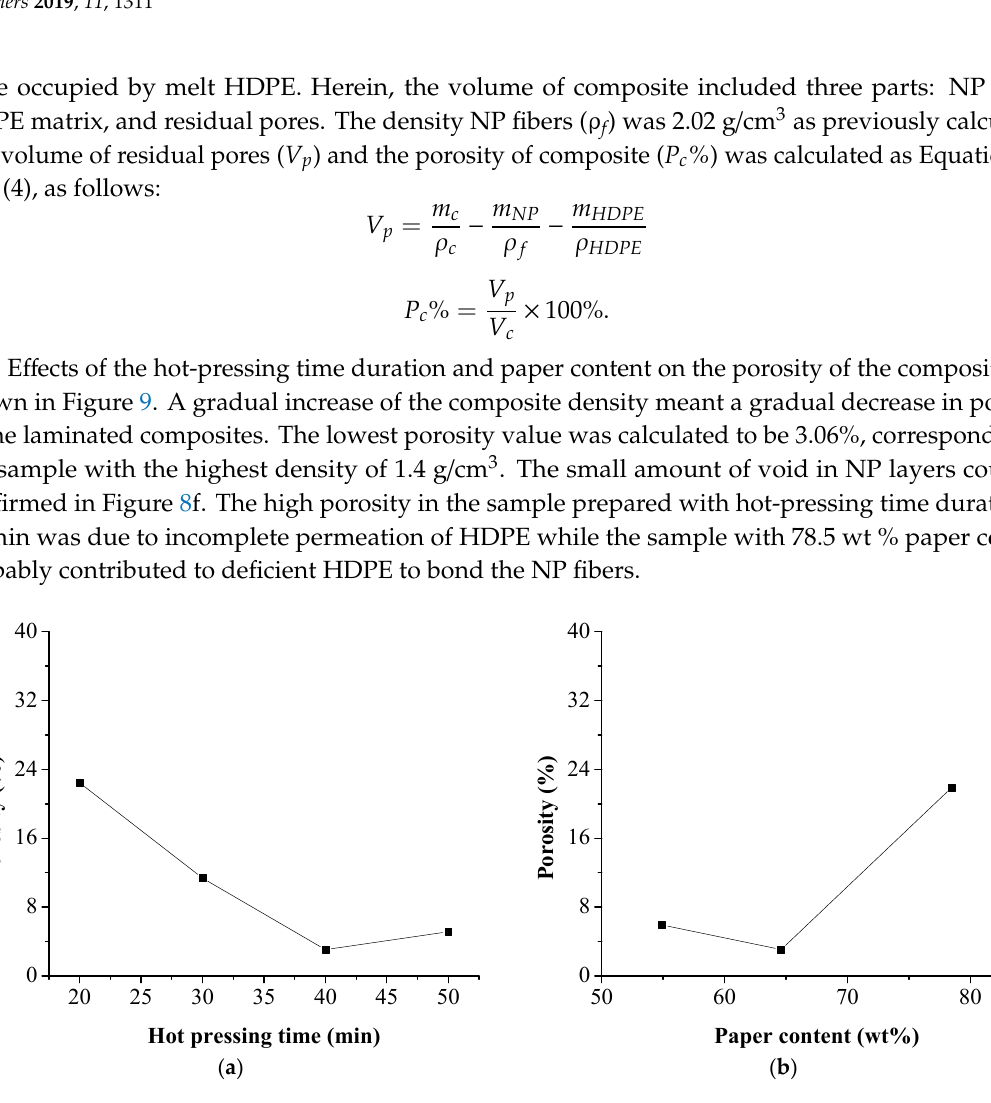
Figure 9. Effect of hot pressing time and NP content on porosity of the laminated composites. ( a ) hot pressing time; ( b ) paper content.